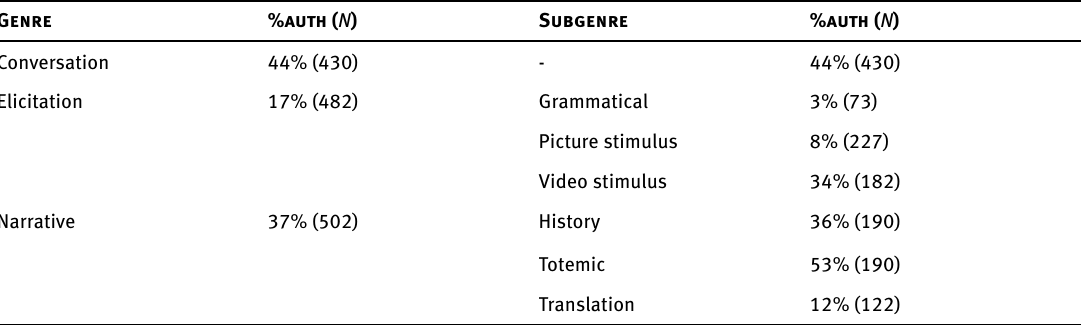
Table 3. Percentage of auth usage by (sub)genre, with total number (N) of eligible verb